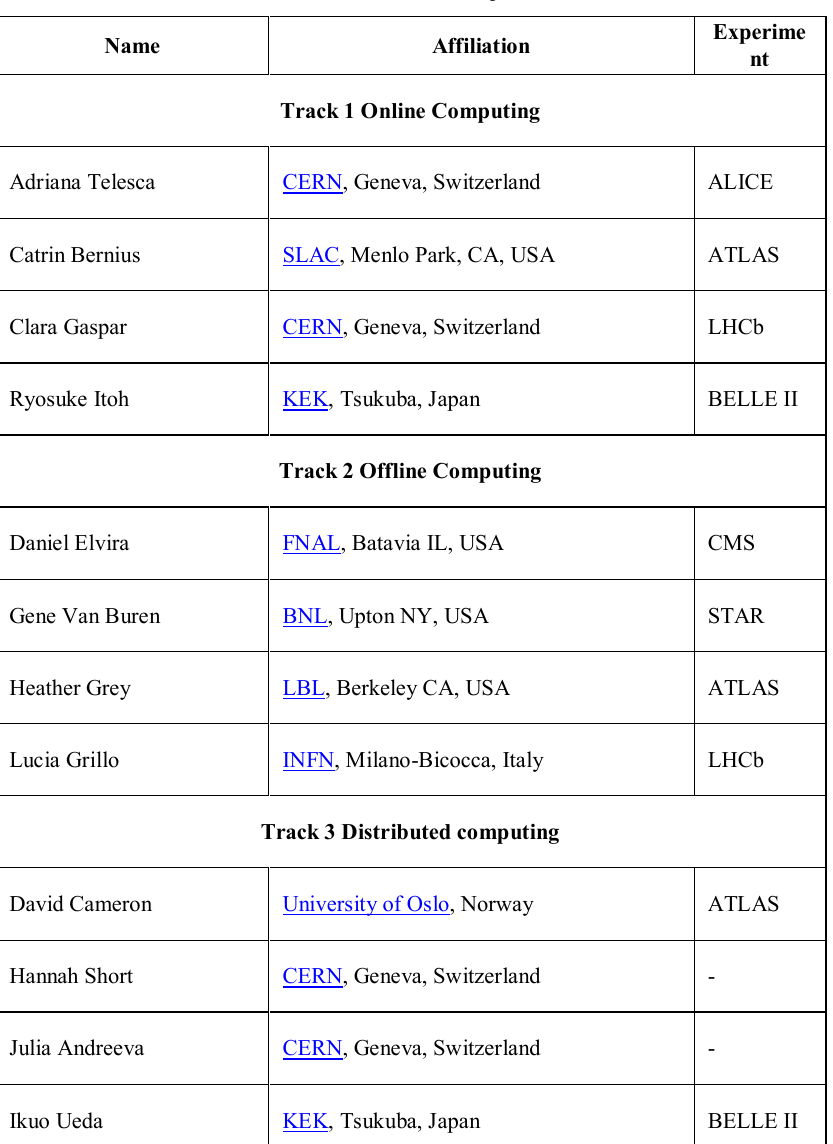
Table 4. List of conveners per